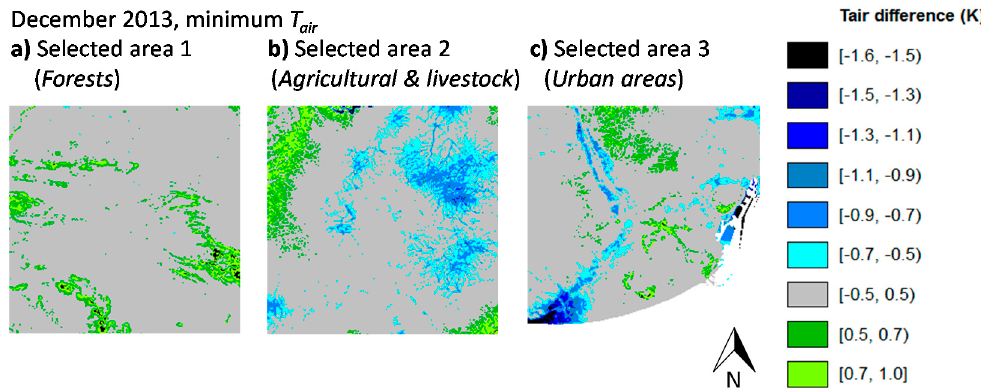
Figure 12. Spatial variation of the difference in the minimum T air estimates provided by models without LST and by models with LST: maps were obtained by subtracting T air (with LST) from T air (no LST). This example corresponds to the model results for December 2013 over three selected areas ( a – c ) mainly characterized by a certain land cover (see their location in Figure 1), and considering all meteorological stations and LST estimates from MYDn.